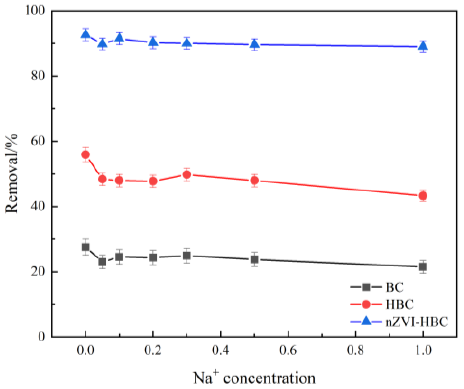
Figure 9. The effect of Na + concentration on OTC removal rate.